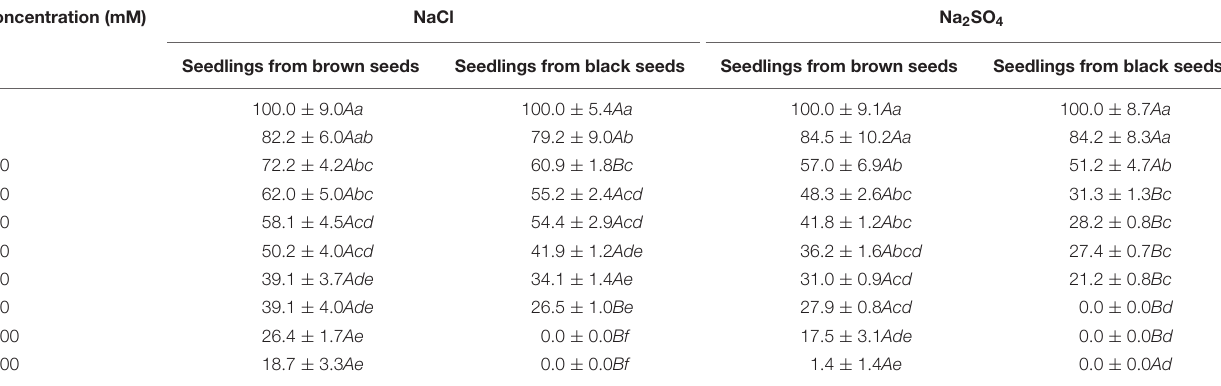
TABLE 6 | Radicle tolerance index of S. salsa seedlings grown from dimorphic seeds treated with different concentration of NaCl or Na 2 SO 4 . Concentration (mM) NaCl Na 2 SO 4 Seedlings from brown seeds Seedlings from black seeds Seedlings from brown seeds Seedlings from black seeds